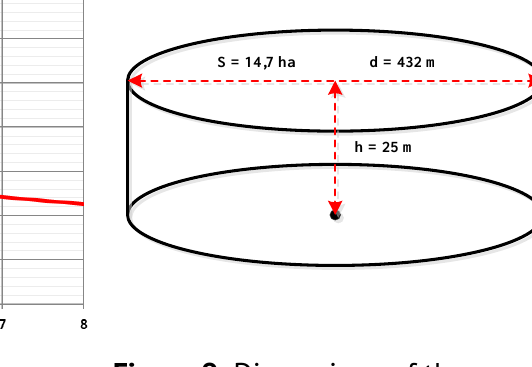
Figure 8. Dependence .